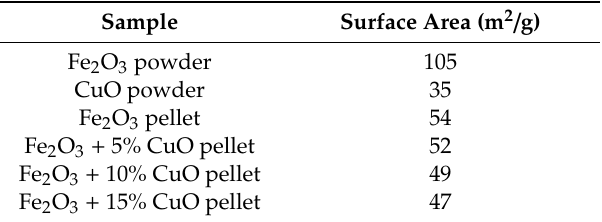
Table 2. BET results for the surface area of pellets and powders.